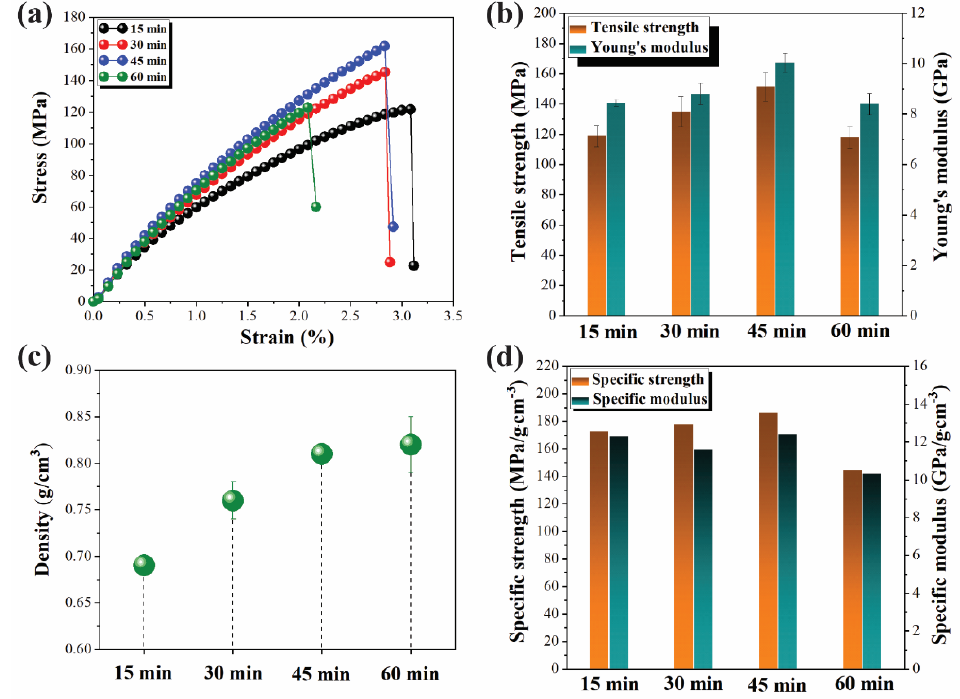
Figure 7. ( a ) Representative stress – strain curves for ACCs made with different impregnation times; ( b ) tensile strength and Young’s modulus of flax-based ACCs as a function of impregnation time; ( c ) density values of ACCs as a function of impregnation time; and ( d ) specific strength and specific modulus of flax-based ACCs as a function of impregnation time.